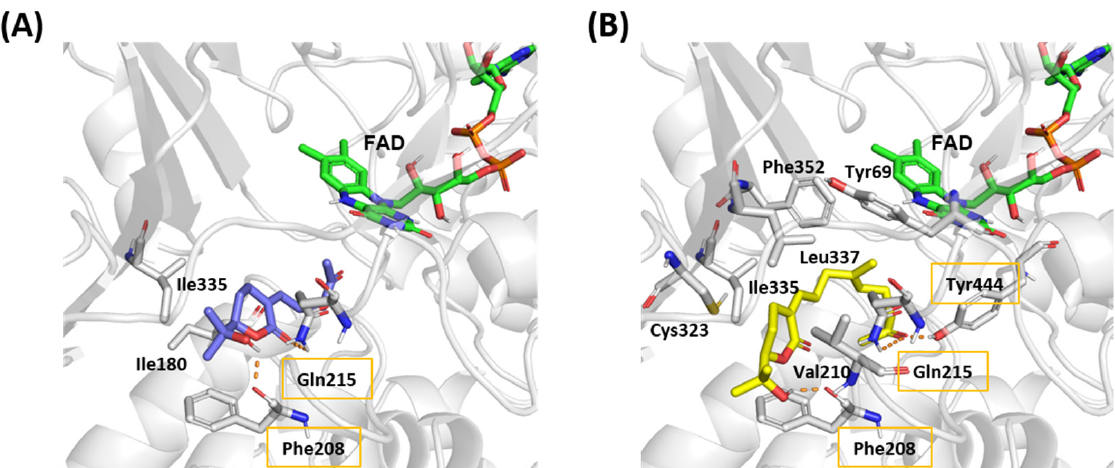
Figure 5. Stereoview of molecular docking poses of compounds 1 ( A ) and 2 ( B ). h MAO-A is shown as a white cartoon and carbon atoms of interacting residues are shown as white sticks. The carbon atoms in docking conformations of two compounds in h MAO-A are shown in blue and yellow sticks, respectively. Carbon atoms of flavin adenine dinucleotide (FAD) are shown as green sticks. FAD was considered as part of a protein during molecular docking. Hydrogen bond interactions are shown as orange dotted lines, and residues that participate in them are labeled with orange boxes. Residues that participate in hydrophobic interactions are labeled without